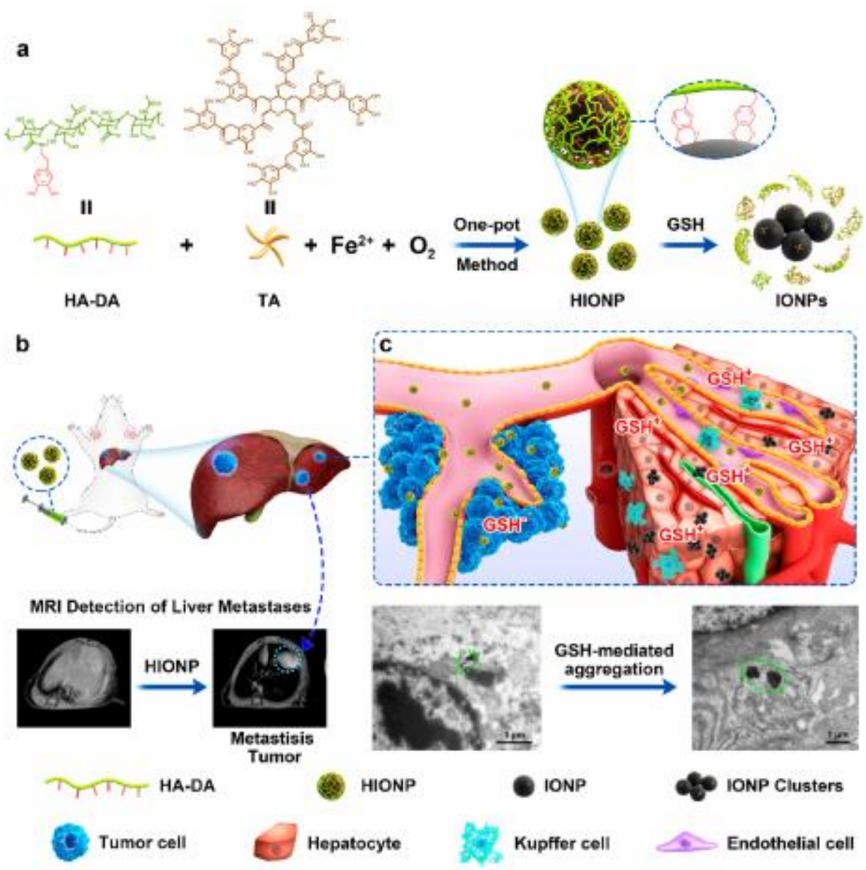
Figure 5. ( a ) Schematic illustration of the production of HIONPs using a one-pot method and the GSH-responsive transformation; ( b ) schematic illustration of GSH-responsive magnetic HIONPs for exceedingly sensitive diagnosis of liver metastases; and ( c ) GSH-mediated conversion of HIONPs in metastasis tumor (non-aggregation state) and liver (aggregation state). Figure adapted with permission from [64], Copyright 2021 American Chemical